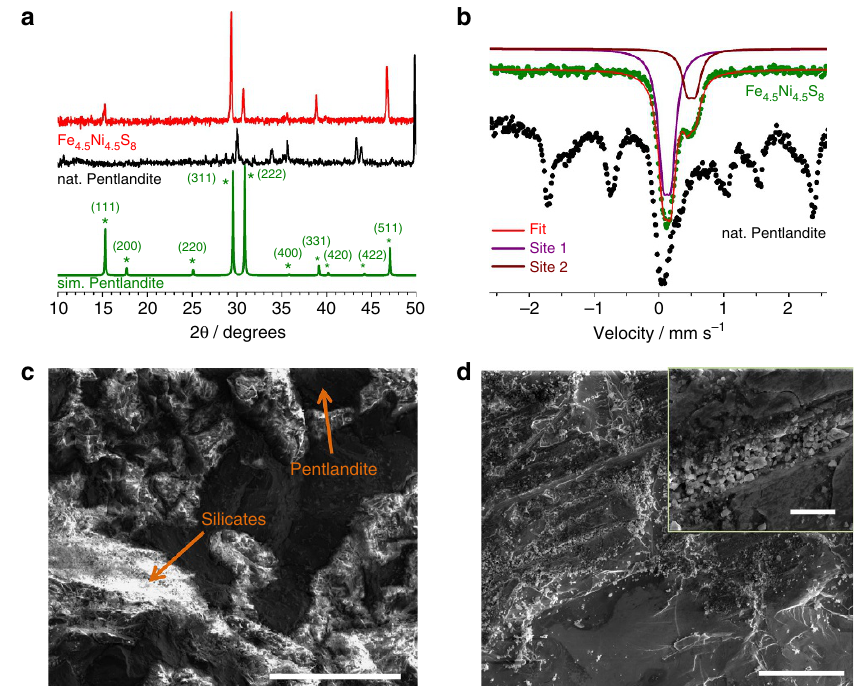
Figure 2 | Characterization of the pentlandites. ( a ) Powder X-ray diffraction pattern for natural and synthesized pentlandites. ( b ) Mo¨ssbauer spectra of natural and synthesized pentlandites. ( c ) SEM image of the natural pentlandite ore (scale bar, 300 m m). Silicates were assigned by EDX spot analysis. ( d ) SEM image of the as synthesized pentlandite with a composition of Ni 4.5 Fe 4.5 S 8 (scale bar, 100 m m). Inset shows the image at higher magnification (scale bar, 10 m